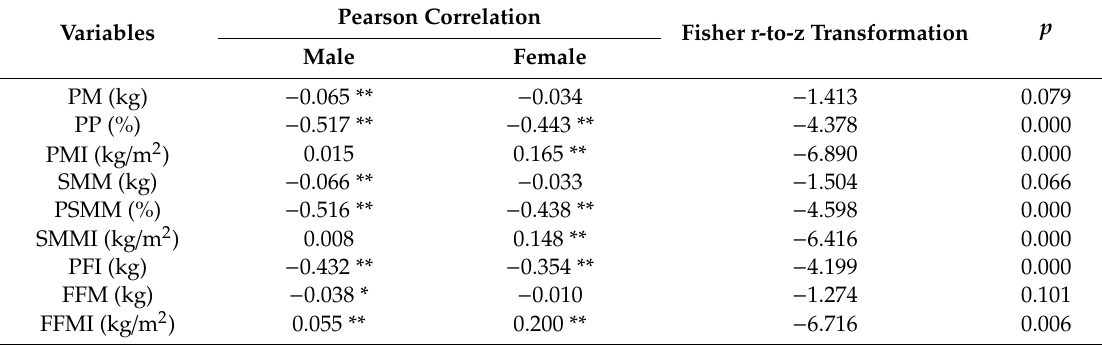
Table 2. Pearson correlation results between age, basic anthropometrics and other muscle mass variables with Fisher r-to-z transformation results.